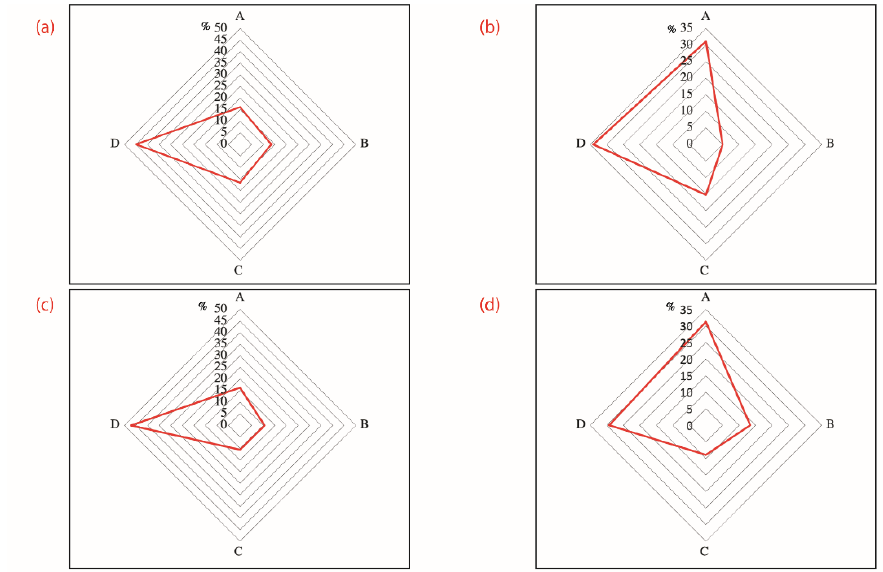
Figure 8. Range analysis of the content of chloride ion of concrete eroded for 30 d ( a ) 0–2 mm concrete samples suffering long-term soaking; ( b ) 2–5 mm concrete samples suffering long-term soaking; ( c ) 0–2 mm concrete samples suffering dry-wet cycling; ( d ) 2–5 mm concrete samples suffering dry–wet cycling.